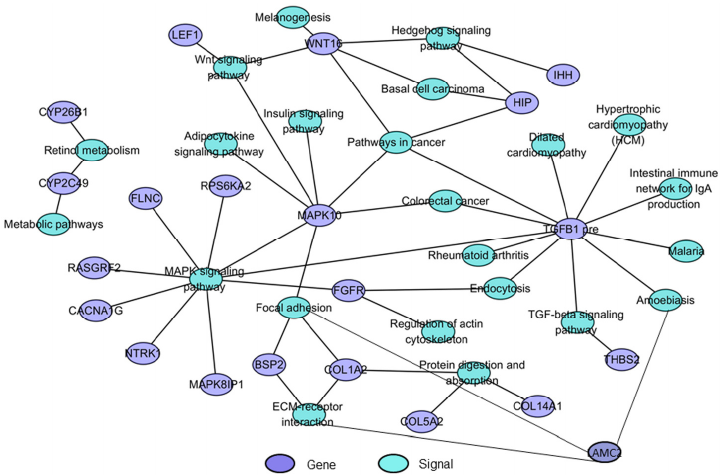
Figure 7. Signal-gene interaction network. Significant DEGs and signals playing important roles during secondary palate development were selected and analyzed by the Signal-Gene construction. Purple cycle nodes represent genes, blue cycle nodes represent signals. Lines between two di ff erent color nodes represent interactions between signals and genes. The more lines of a signal, the more genes it involves, and vice